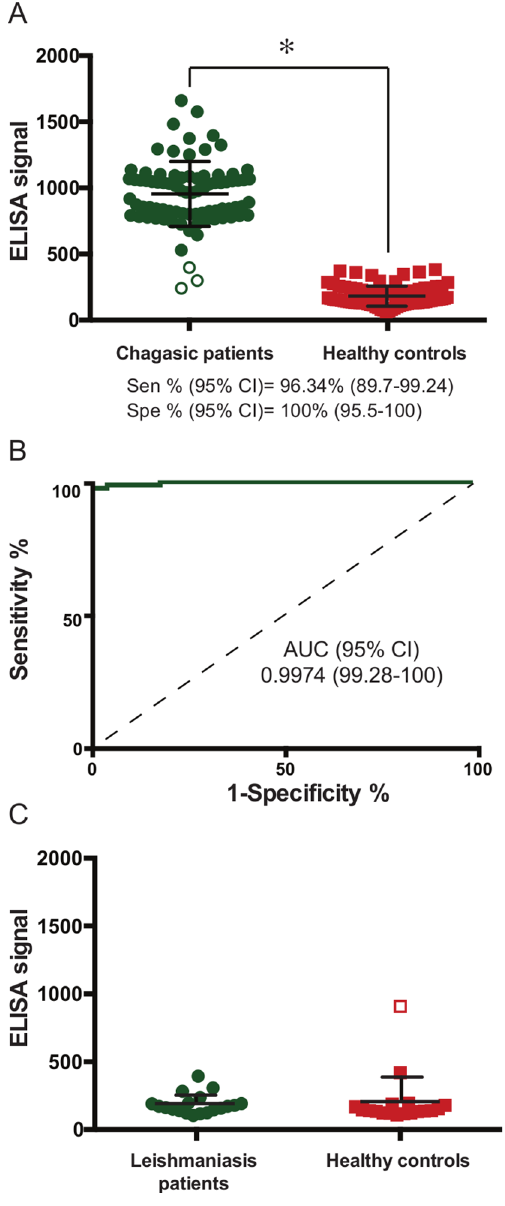
Fig 3. Diagnostic performance of the final multiepitope formulation. A) Scatter plot showingthe distribution of ELISA raw signalobtainedfrom sera samples of Chagas-positive (green circles) and healthy subjects(red squares). Statistical significance( * ) p < 0.0001,Mann-Whitney test. Green empty circles in the left scatter plot represent those within 3 standarddeviationsof the averagesignalof healthy controls. B) Receiver OperatingCharacteristic curve and statistics for the analysis. C) Scatter plot showingthe distribution of ELISA raw signal obtainedfrom Leishmaniasis-positive(green cirles) and Leishmaniasis-negative subjects from the same co-endemic region(red squares). Empty circles represent data points that fall at > 3 SD from their respectivedistributions.